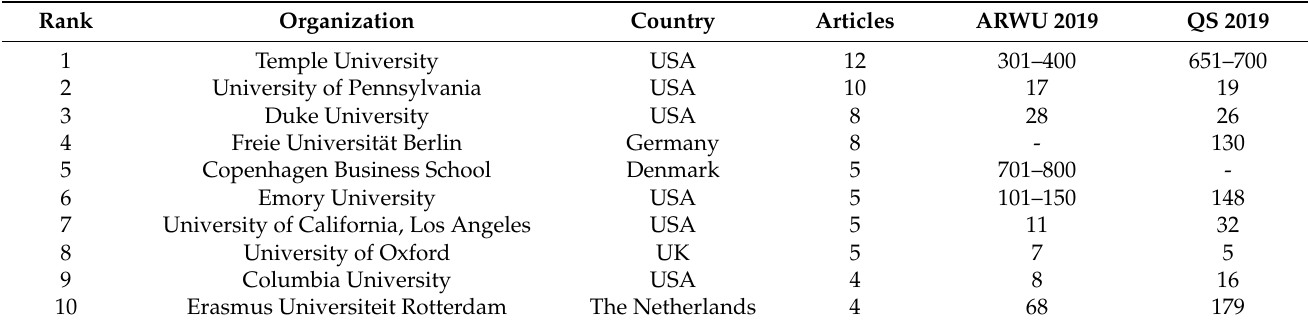
Table 12. Top 10 Most Relevant Affiliations.